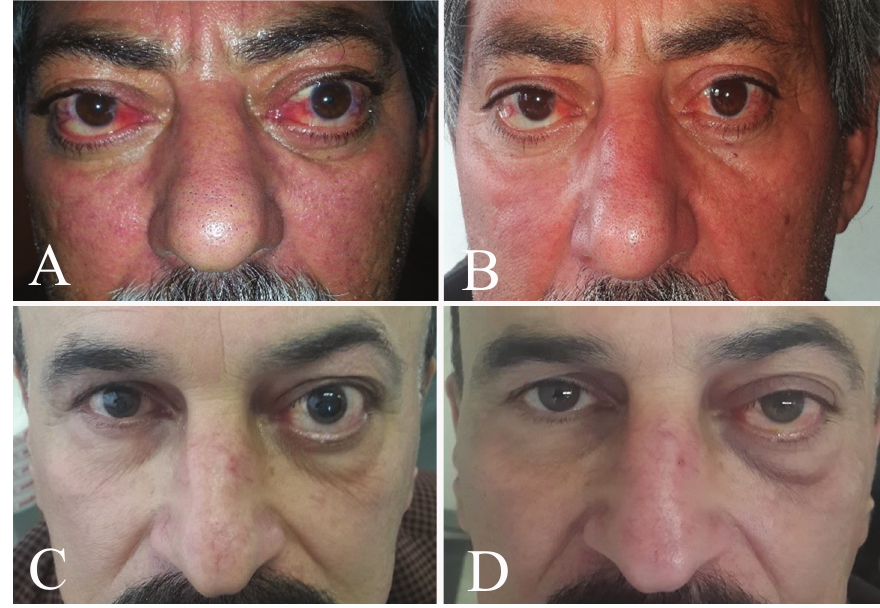
Figure 4. Two representative patients before injections (A,C) and at final examinations